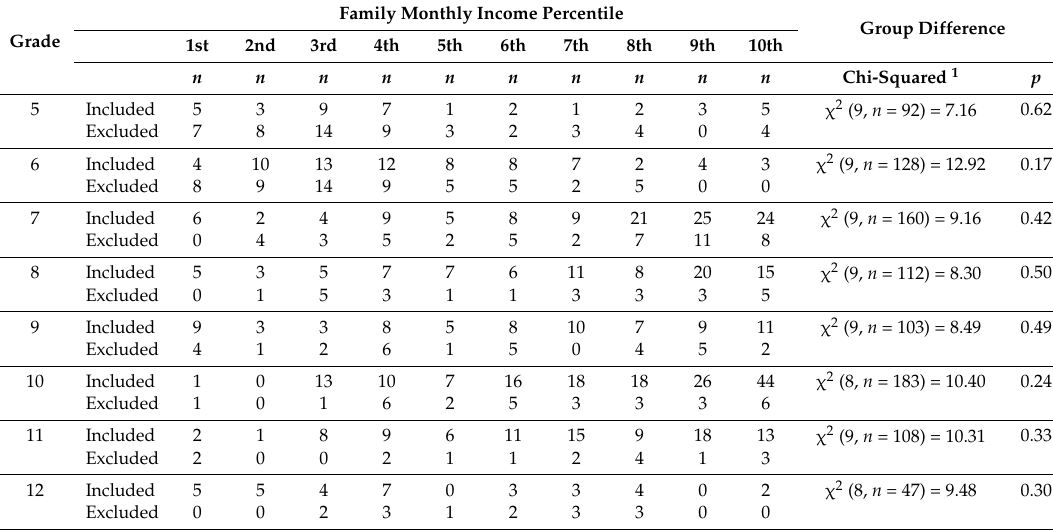
Table A3. Difference in family monthly income percentile between included and excluded respondents by